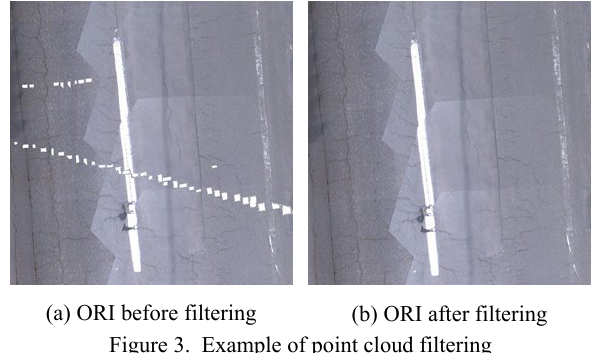
Figure 3. Example of point cloud filtering